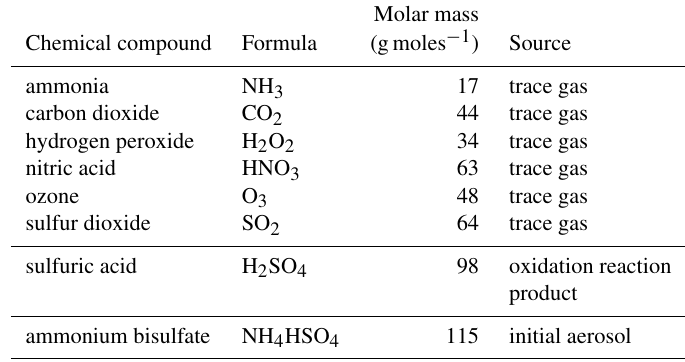
Table C1. Chemical compounds considered in this work.